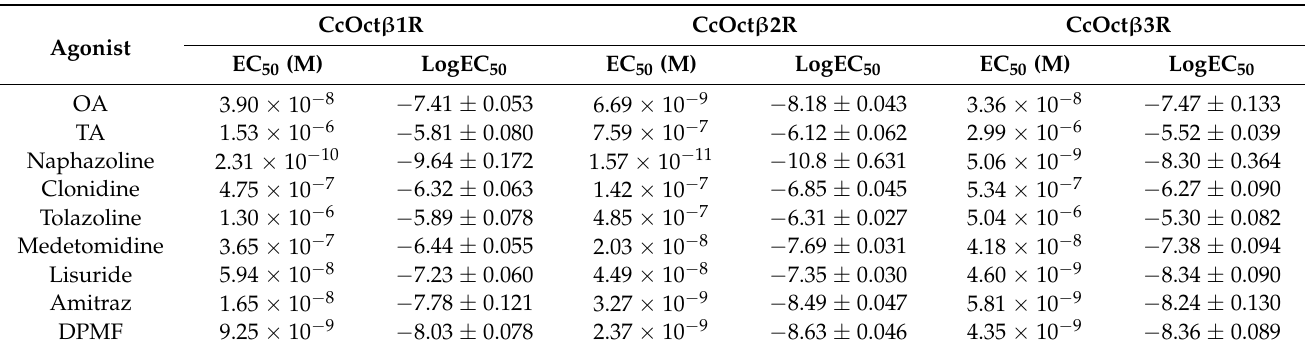
Table 1. EC 50 and LogEC 50 values for activation of cAMP response in CcOct β R-expressing CHO-K1 cells by various agonists.